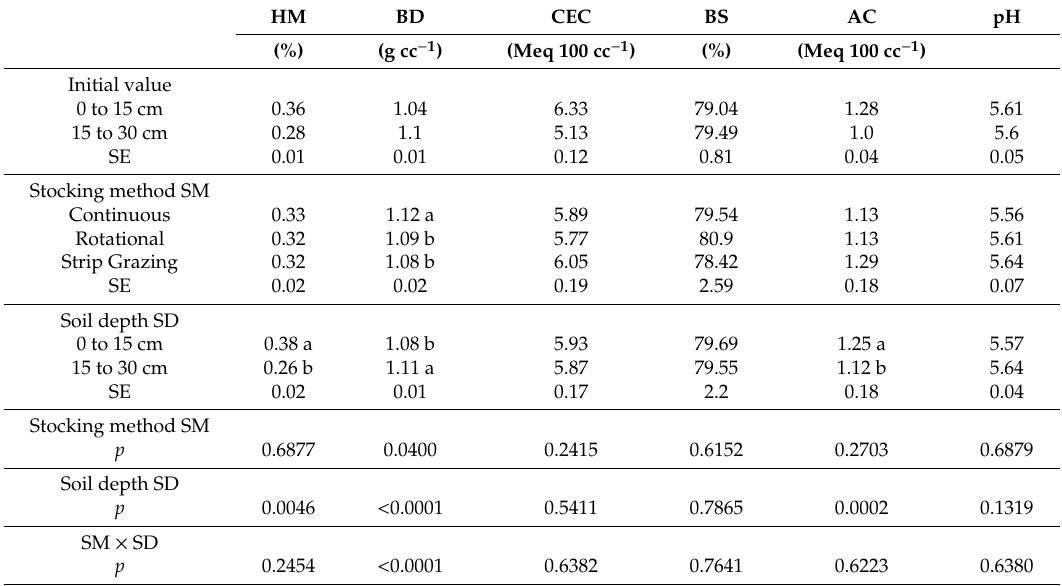
Table 2. E ff ect of stocking methods and soil sampling depths on the chemical-physical soil properties of tall fescue paddocks managed with growing-finishing